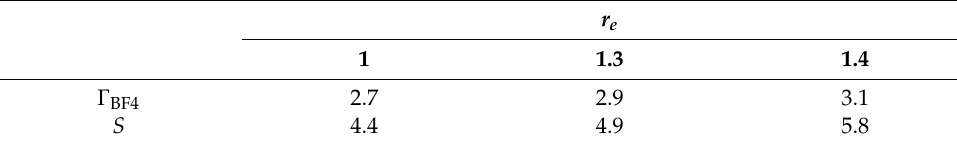
Table 2. Partition coefficient and selectivity of [BF4] − , φ s = 1 V and X BF4 = 0.5.